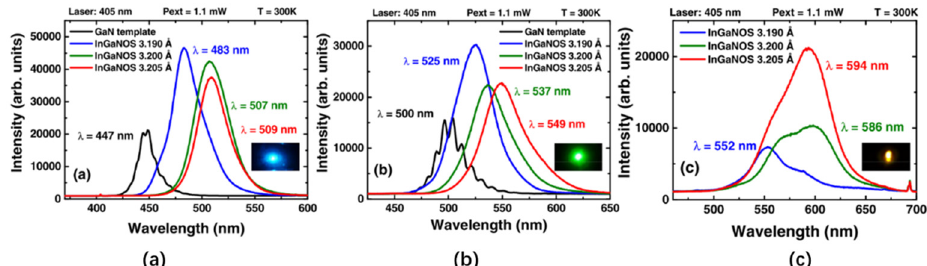
Figure 17. ( a – c ) are the PL (photoluminescence) spectras at 300 K of the blue, green, and amber InGaN heterostructures grown in InGaNOS under three growth conditions. The insets in the lower right corner are emission diagrams of the InGaNOS samples under laser excitation, where ( a ) blue luminescence is observed for InGaNOS with a = 3.190 Å grown at a growth temperature and rate of 750 ◦ C and 0.1 lm / h, respectively; ( b ) green luminescence is observed for InGaNOS with a = 3.200 Å grown at a growth temperature and rate of 730 ◦ C and 0.1 lm / h, respectively; ( c ) amber luminescence is observed for InGaNOS with a = 3.205 Å grown at a growth temperature and rate of 720 ◦ C and 0.3 lm / h, respectively. Reproduced from [102], with permission from American Institute of Physics, 2017.